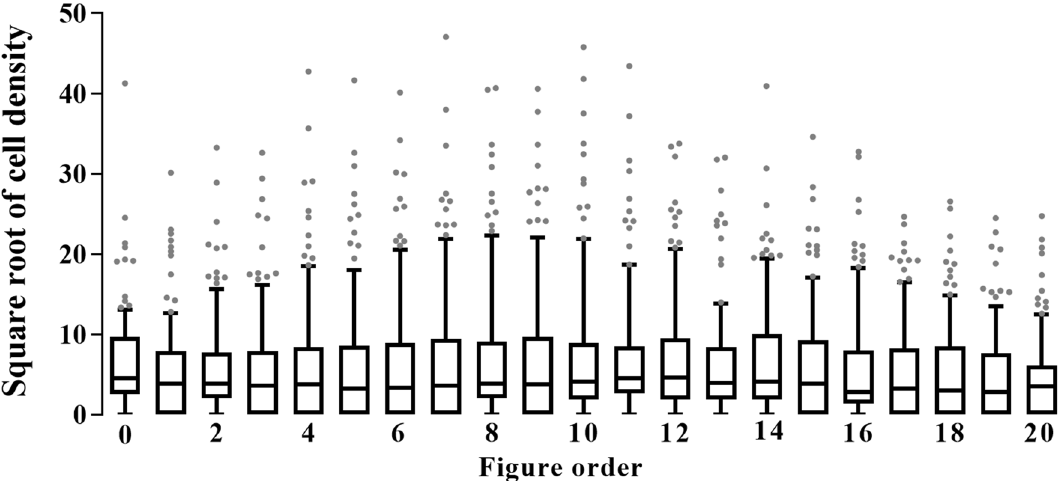
Figure 2. Cell density according to the location of imaging. Images 0 and 20 refer to the top and bottom of the anterior chamber, respectively. There were no significant differences in cell density in all areas of the anterior chamber ( p = 0.2773, Kruskal–Wallis chi-squared test). The boxes indicate the median and interquartile range, and the whiskers indicate 10–90